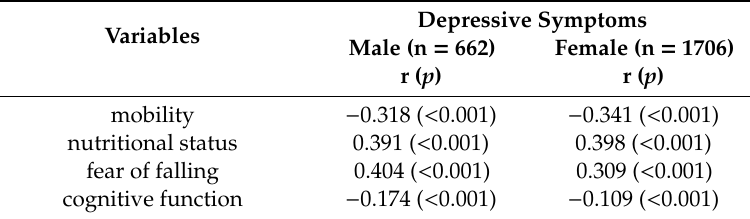
Table 3. Sex di ff erences in the correlation between study variable and depressive symptoms of older people in the prefrailty phase (n = 2368).